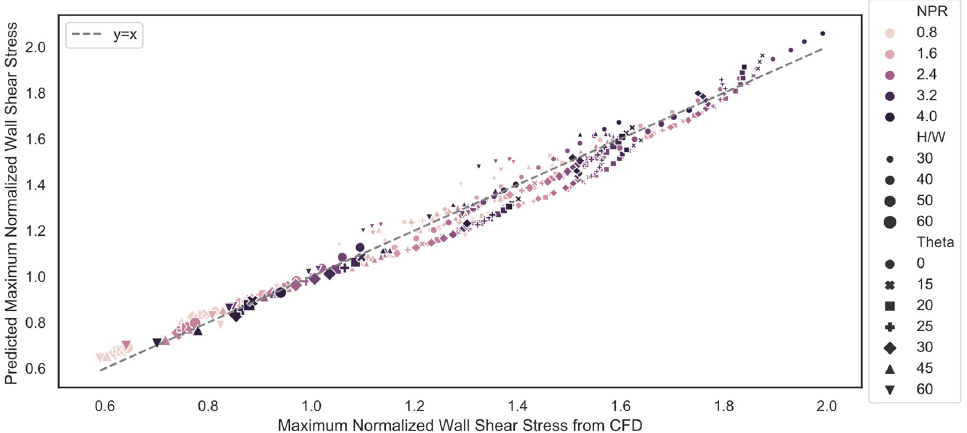
Figure 6. Predicted maximum normalized wall shear stress plotted against maximum normalized wall shear stress from CFD for all impingement angles. Shade represents the nozzle pressure ratio, the symbol represents the impingement angle, and the marker size represents the height-to-width